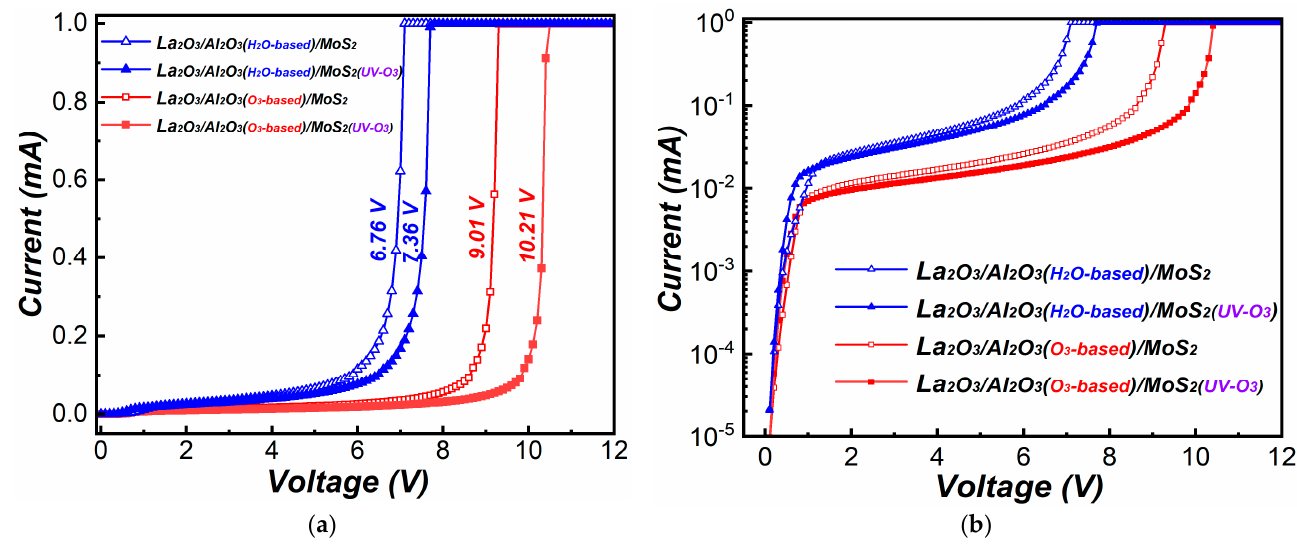
Figure 10. ( a ) Linear-scale and ( b ) log-scale I-V curves of MOS capacitors for La 2 O 3 /Al 2 O 3 nanolaminates on MoS 2 .